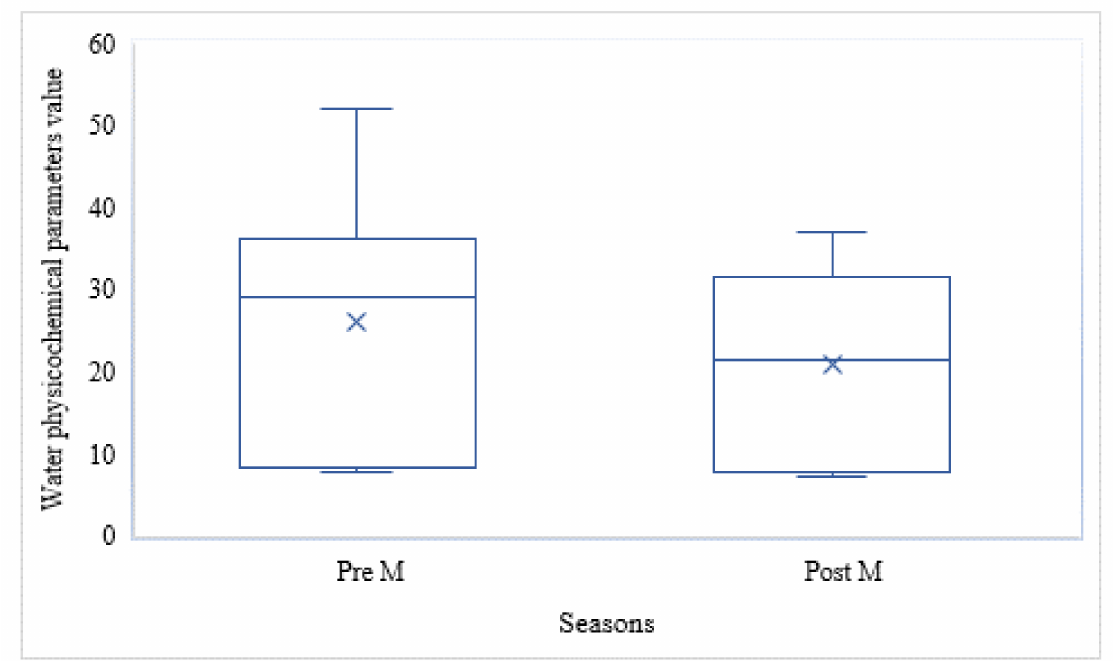
Figure 2. Seasonal variation of water quality